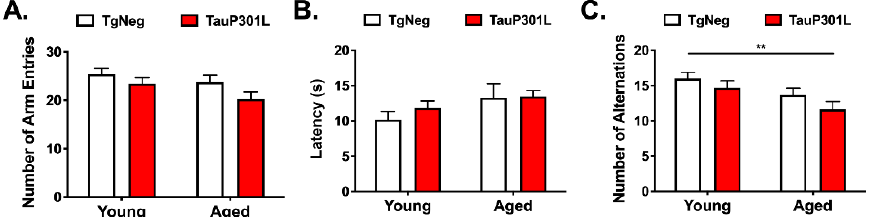
Figure 3. Aged-P301L mice exhibit deficits in the Y-Maze. No differences were observed among the groups for number of arm entries ( A ) or latency to begin exploring the maze ( B ), whereas the num- ber of triads were reduced in Aged-P301L mice ( C ). ** p < 0.01; n = 12 –